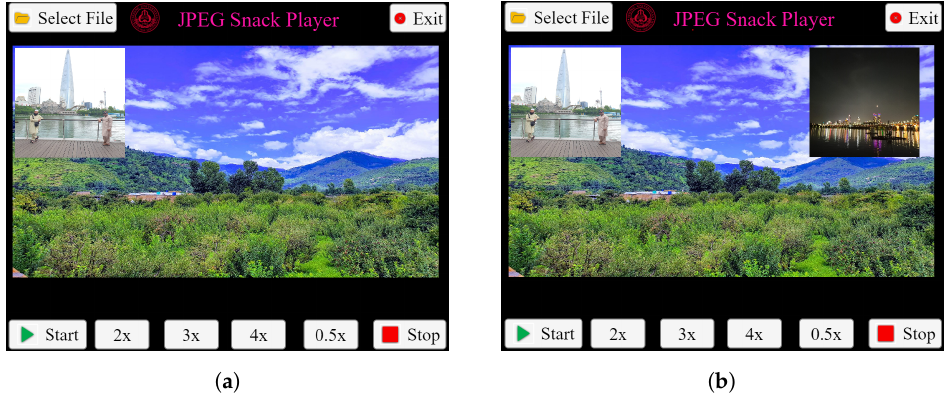
Figure 8. JPEG Snack Player playing JPEG Snack file with 2 JPEG Objects embedded in it. ( a ) Object 1 is displayed after 2 s. ( b ) After 3 s, Object 2 appears.